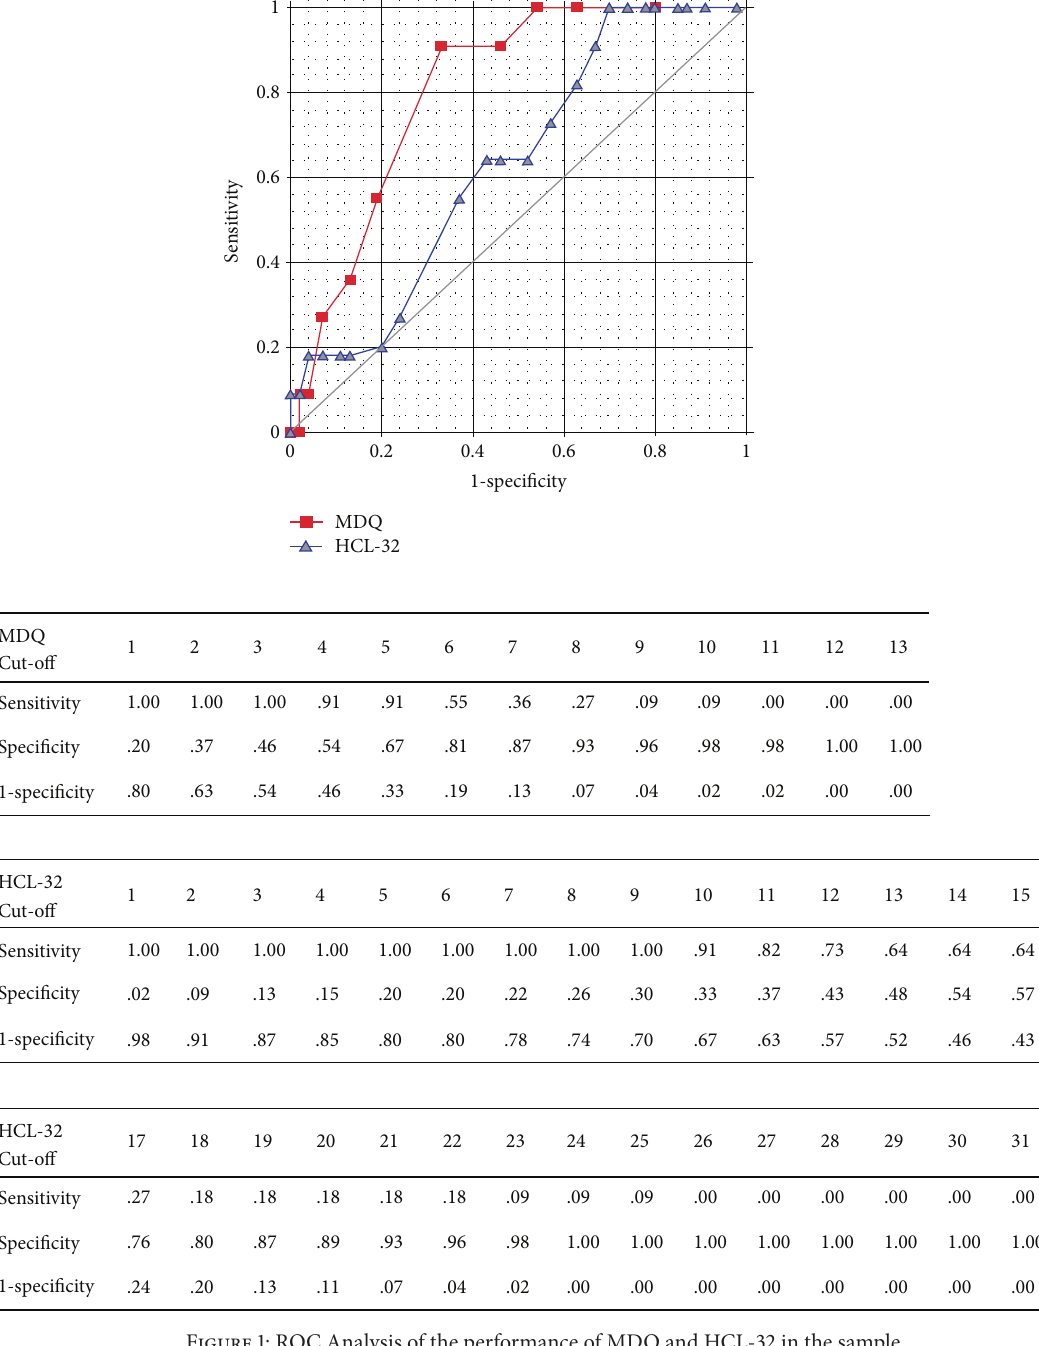
Figure 1: ROC Analysis of the performance of MDQ and HCL-32 in the